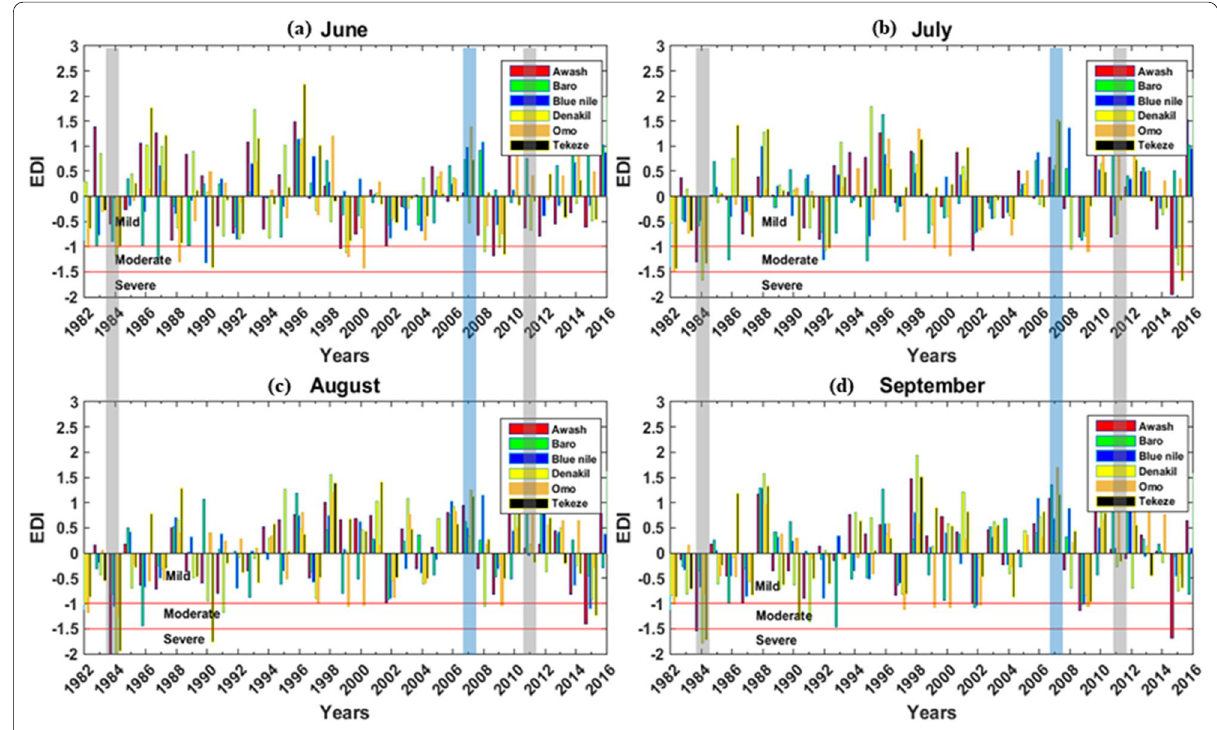
Fig. 4 Time series plots of basin-wide EDI values during main rainfall months ( a – d ) between 1982 and